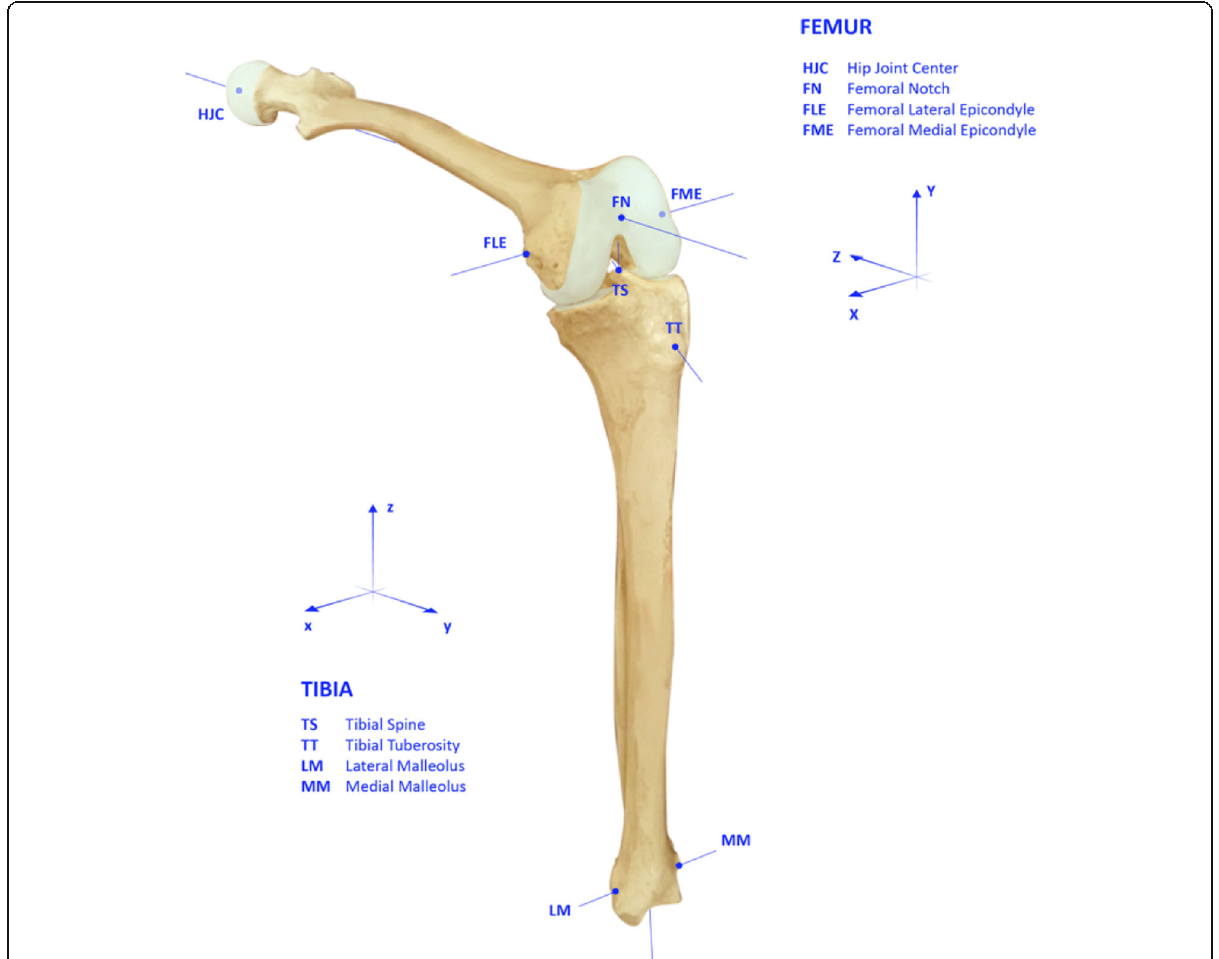
Fig. 1 Anatomical reference systems used for the kinematic